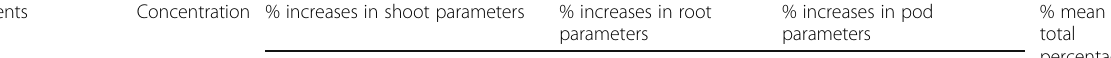
% increases in pod % mean parameters parameters total percentages of plant growth and yield